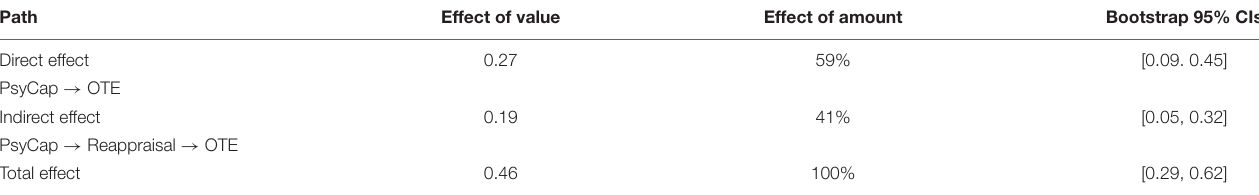
TABLE 4 | Bootstrap analysis of significance test of mediation